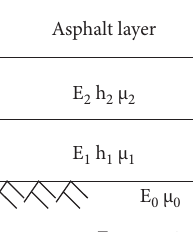
Figure 1: Conversion model of equivalent principle of